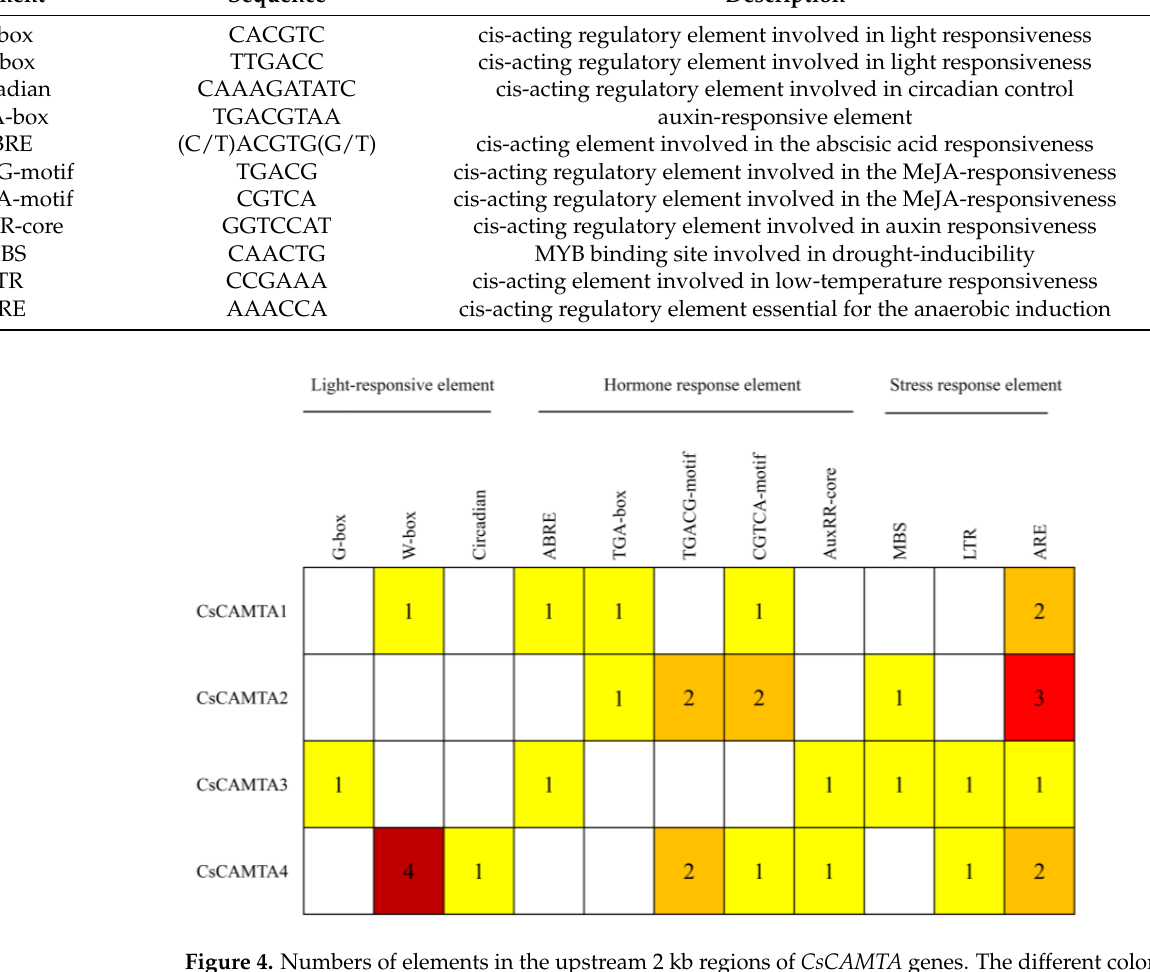
Figure 4. Numbers of elements in the upstream 2 kb regions of CsCAMTA genes. The different colors and numbers of the grid indicate the numbers of different Cis-acting regulatory elements in these CsCAMTA genes.